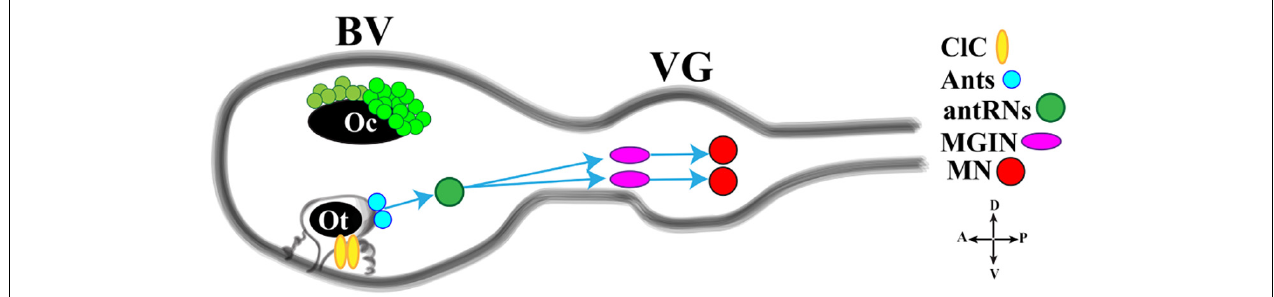
FIGURE 4 | Cartoon of a Ciona tadpole larva Central Nervous System showing the minimal gravitaxis circuit. D., dorsal; V., ventral; A., anterior; P., posterior; ClC, ciliated cells; Ants: glutamatergic antennae sensory neurons; antRNS, GABAergic antenna Relay Neurons; MGIN, Motor Ganglion Inter Neuron; MN, Motor Neuron. BV, Brain Vesicle; VG, Visceral Ganglion. Adapted from Kourakis et al. (2019) and Bostwick et al.